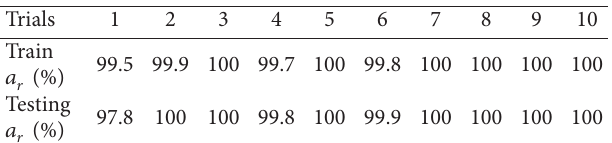
Table 9: Results of 10 trials of the proposed model.